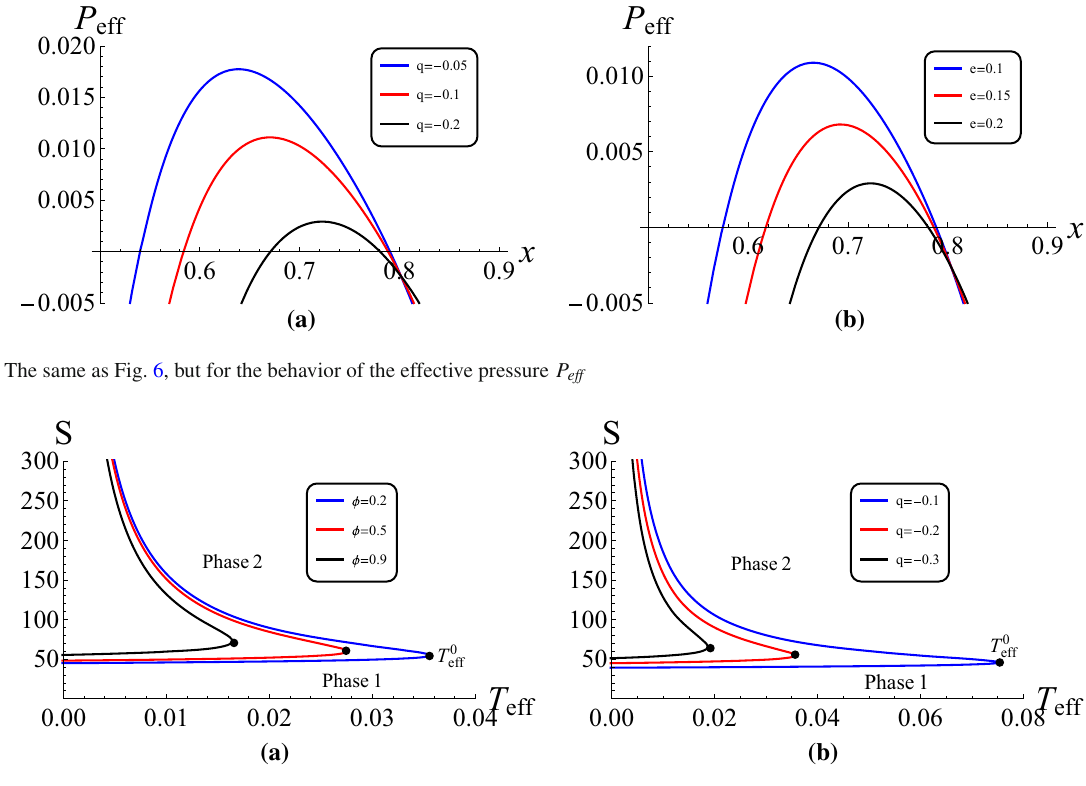
Fig. 8 The S − T eff diagram with different φ eff (while q is fixed at − 0.2) and different q (while φ eff is fixed at 0.2)